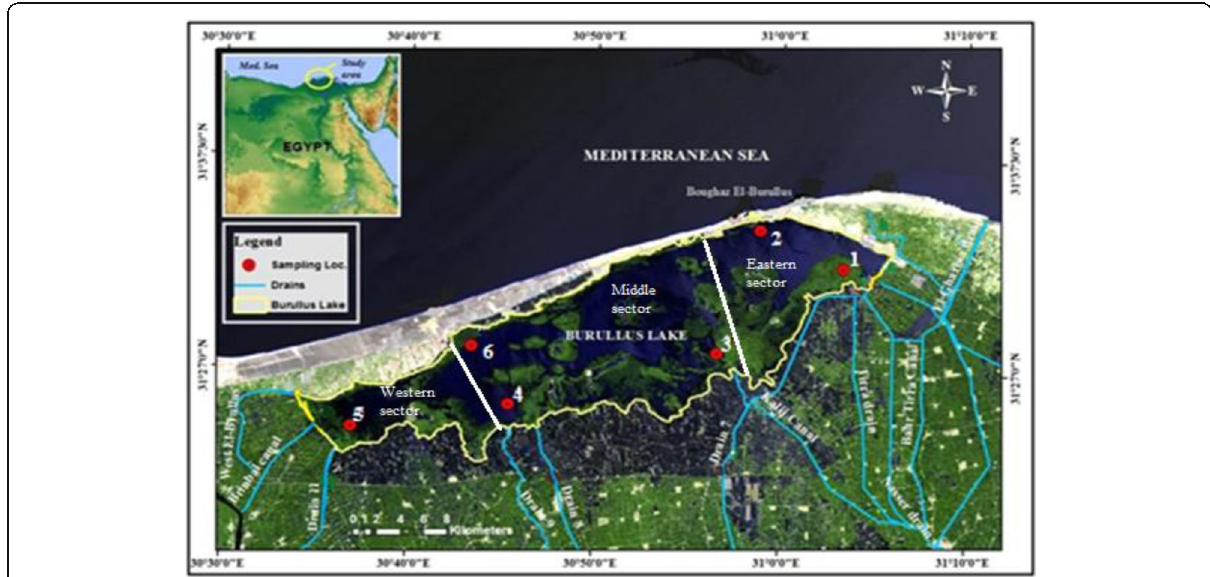
Fig. 1 Map of Burullus Lake showing the sampling